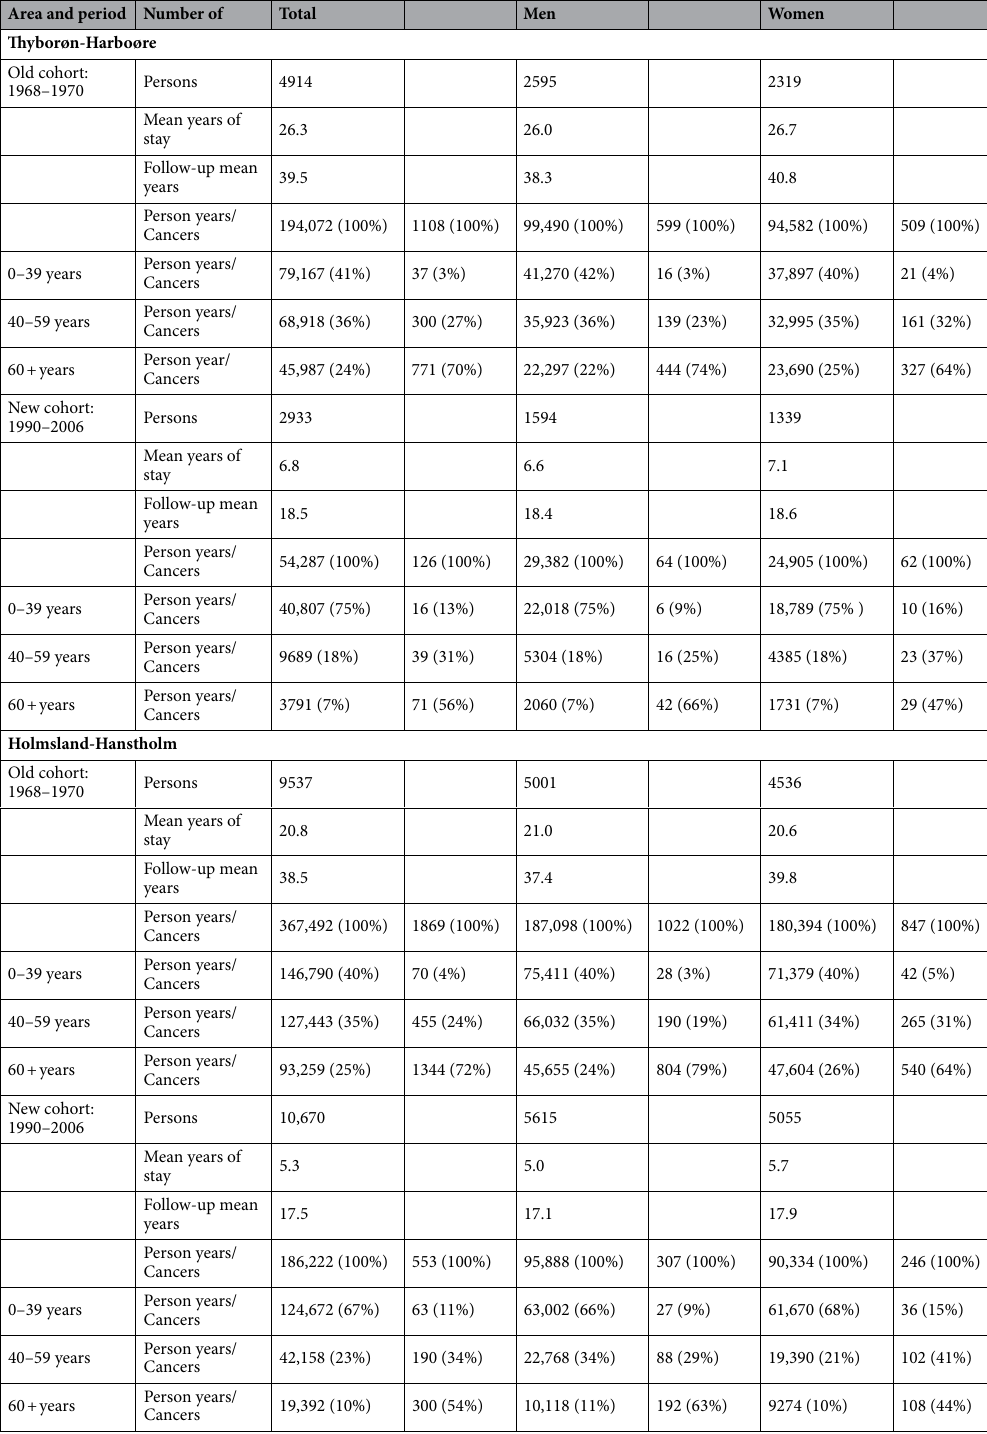
Table 1. Thyborøn-Harboøre and Holmsland-Hanstholm, Denmark. Number of persons, follow-up, person- years, and cancer cases 1968–1970 and